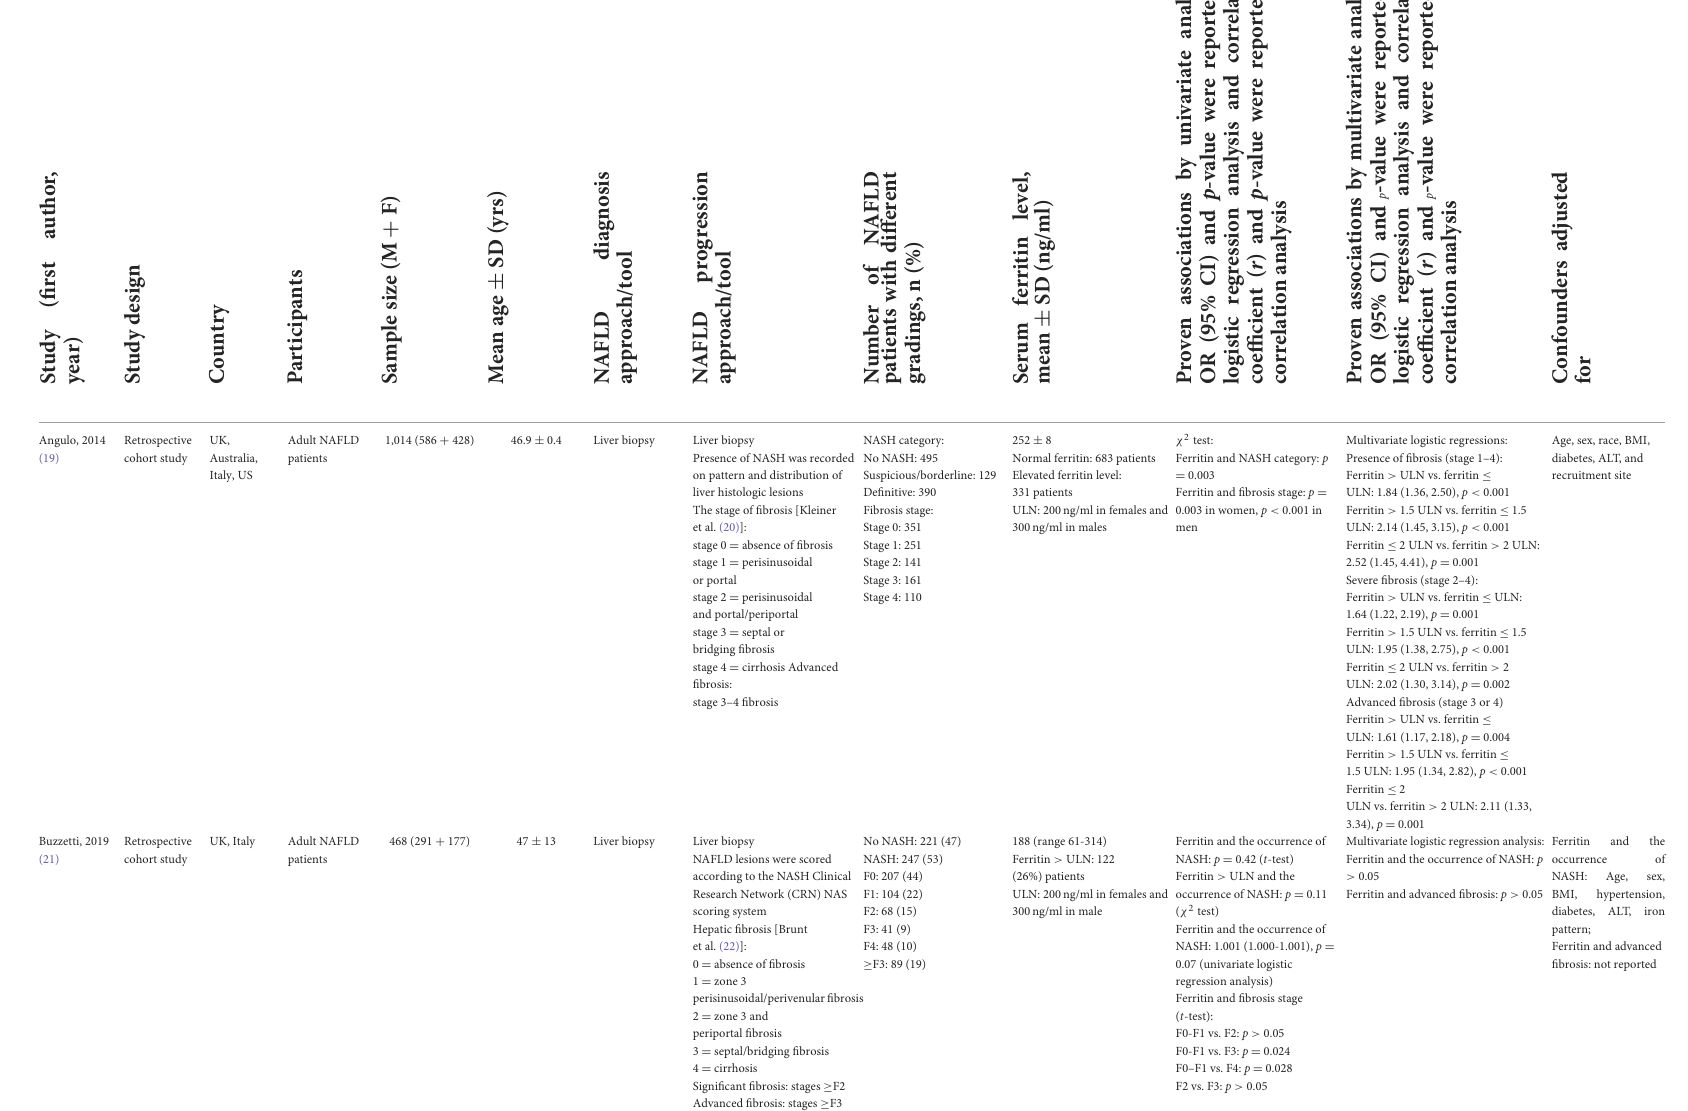
TABLE 1 Characteristics and findings of included studies.